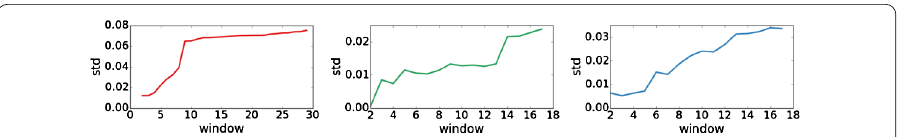
Figure 14 Number of collective footprints validation. Standard deviation of the silhouette coefficients for number of clusters k in a growing window with respect to a selected number of clusters: k = 45 for UniCoop, k = 12 for Ta-Feng and k = 15 for T-Mall. On the x axis is reported the size of the window, i.e., the number of silhouette coefficients considered with respect to the selected. On the y axis is reported the standard deviation of the silhouette coefficients in the window centered in the selected